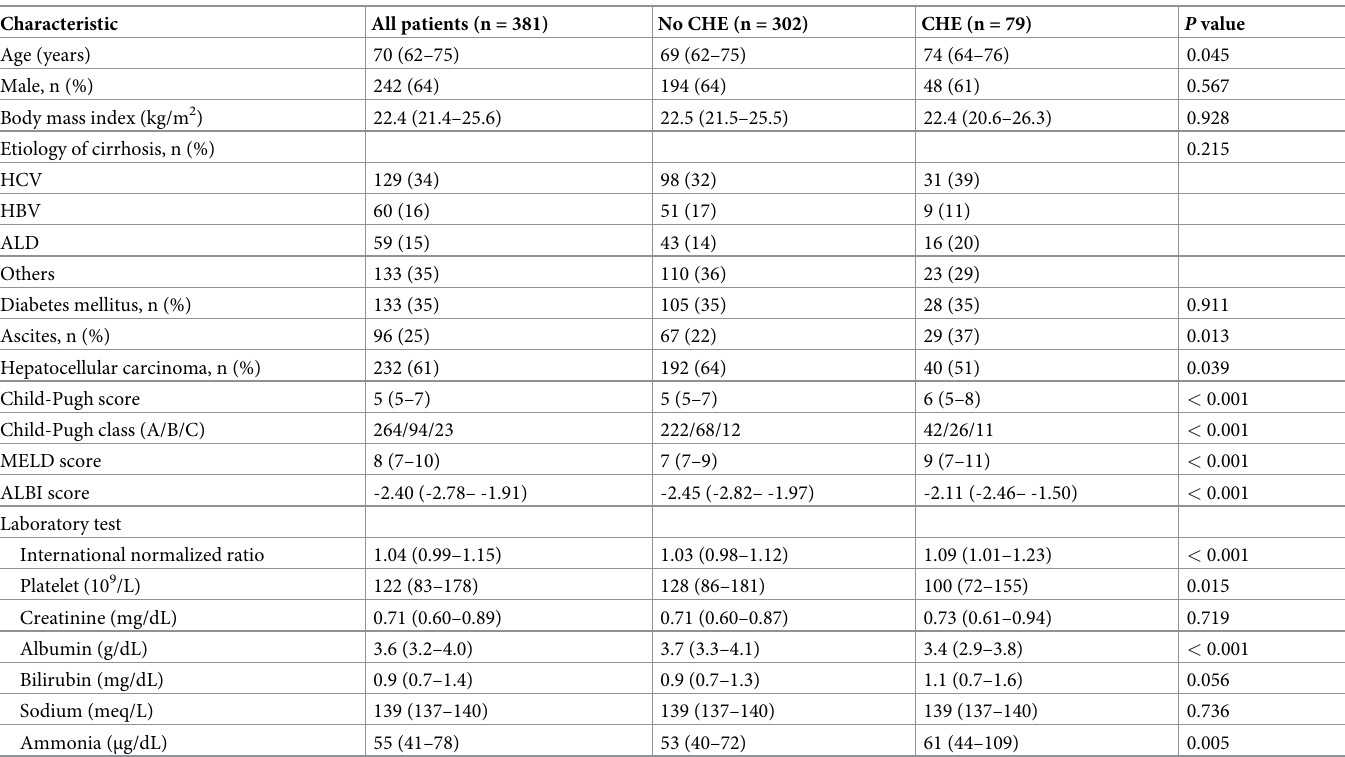
Table 1. Baseline characteristics of the patients with cirrhosis.